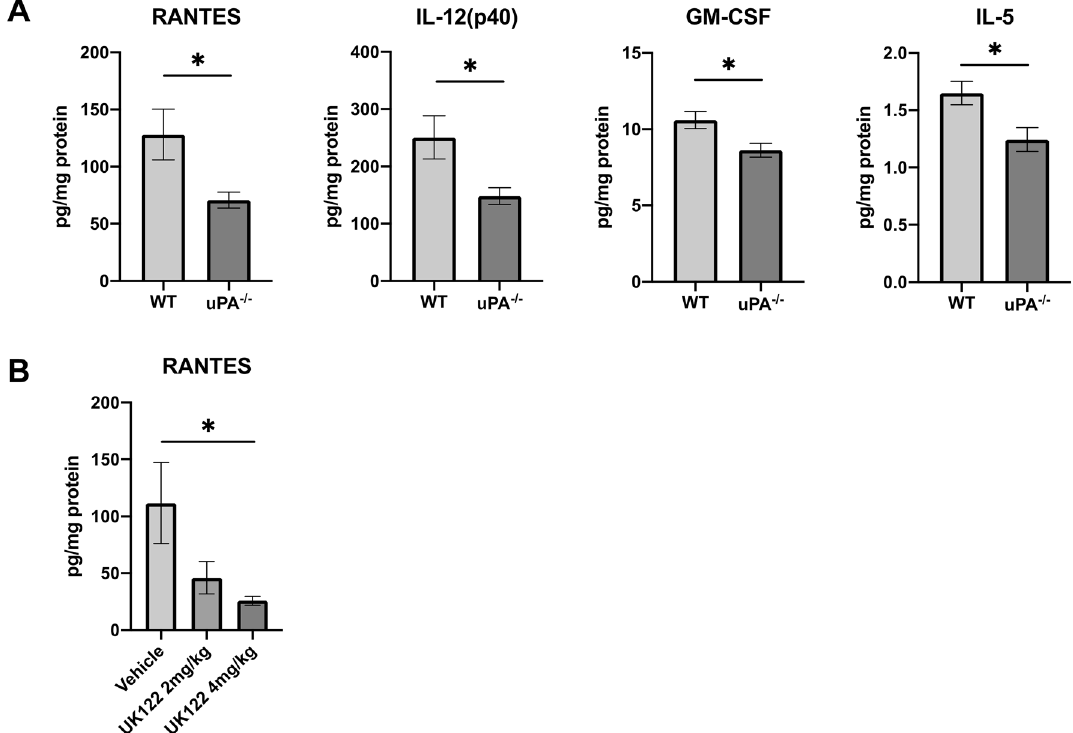
Figure 6. Cytokine expression in colorectal tissue from DSS-treated uPA −/− mice, and C57BL/6 J mice intraperitoneally injected with UK122. ( A ) Cytokine concentration in the colorectal extracts of WT (n = 8) and uPA −/− (n = 10) mice measured using Bio-Plex Pro Mouse Cytokine 23-Plex Assay kit in triplicate. ( B ) Cytokine concentration in the colorectal extracts of 8 mice treated with 2 mg/kg or 4 mg/kg UK122 or vehicle measured using Bio-Plex Pro Mouse Cytokine 23-Plex Assay kit in duplicate. Data represent mean ± SEM. * p < 0.05, by Student’s t test ( A ) and Dunnett’s multiple comparison test ( B